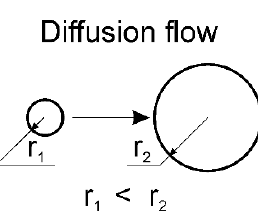
Figure 4. Diffusion flow according to L-S-W theory [30]. Diffusion flow is equal to